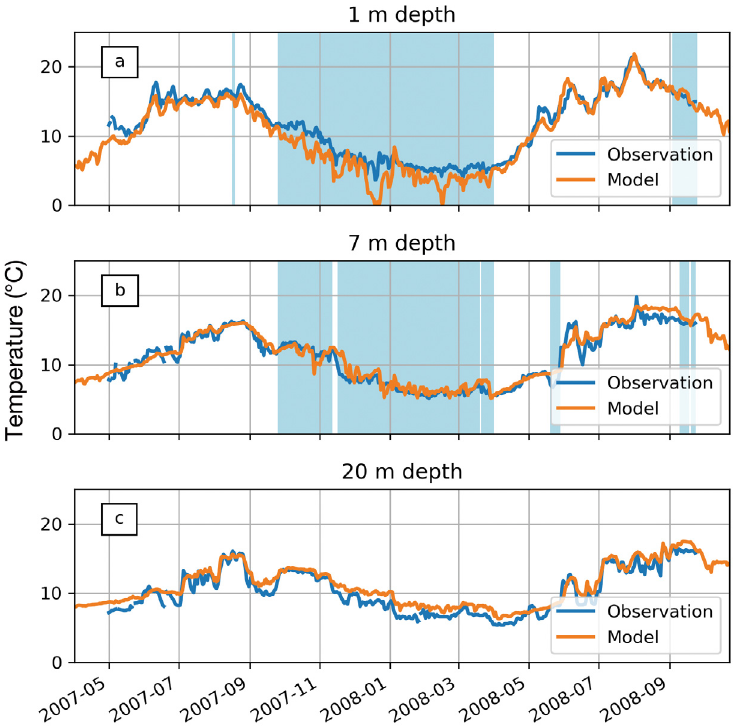
Fig. 3. Observed and simulated temperatures at (a) 1 m, (b) 7 m and (c) 20 m depth at farm site Langavika. Shaded areas: time periods when temperature was higher at 20 m than at 1 or 7 m